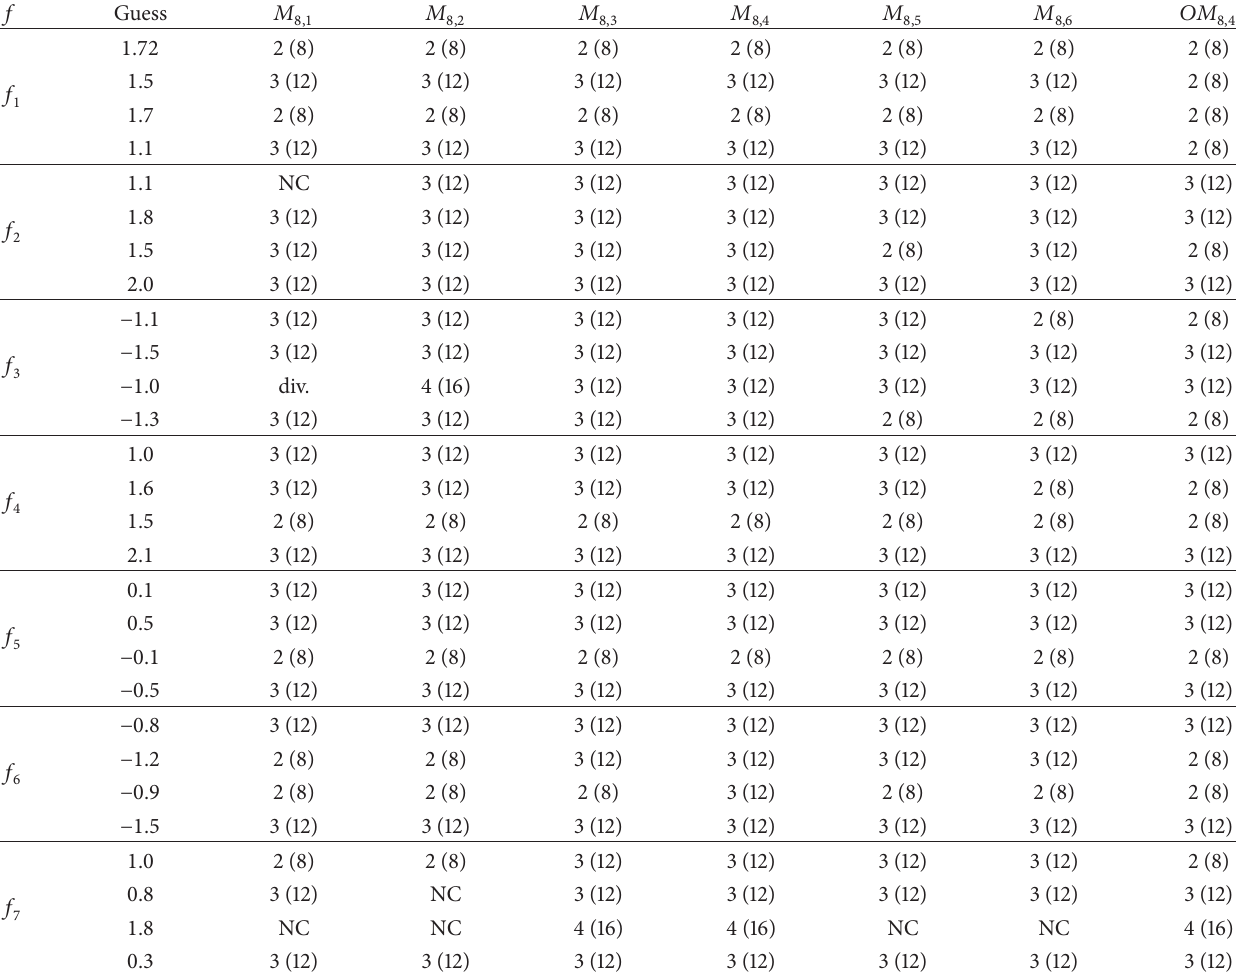
Table 3: Comparison of number of iterations and total number of function evaluations.